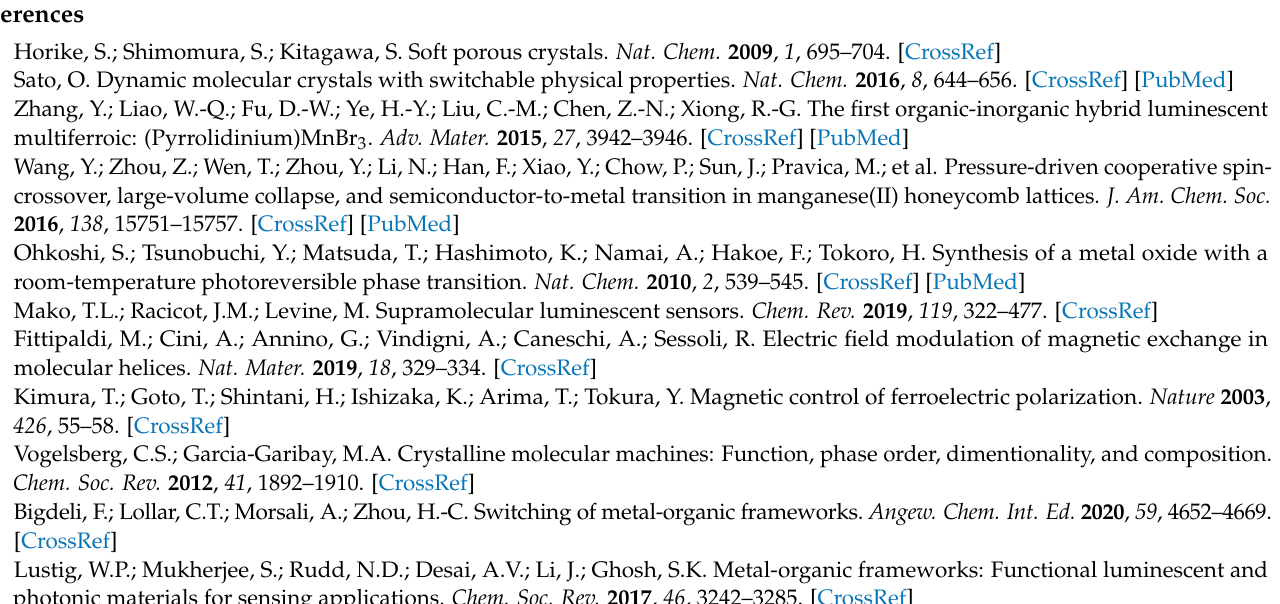
Supplementary Materials: Figure S1, Table S1: IR spectra, Figure S2: TG curves, Table S2: selected struc- tural parameters, Tables S3 and S4: CSM analysis, Figure S3: asymmetric units, Table S5–S6: hydrogen bond parameters, Figure S4: views of the H-bonds, Table S5: PXRD patterns, Table S6: additional